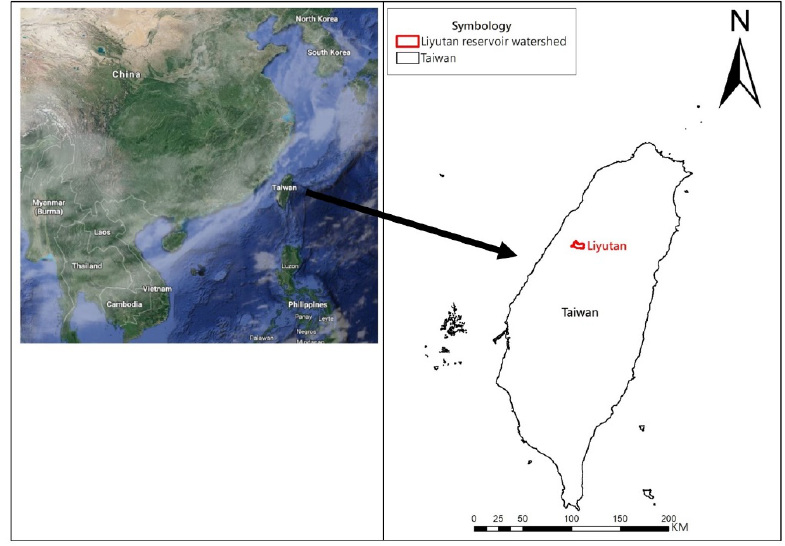
Figure 1. Location of Taiwan and the Liyutan reservoir.